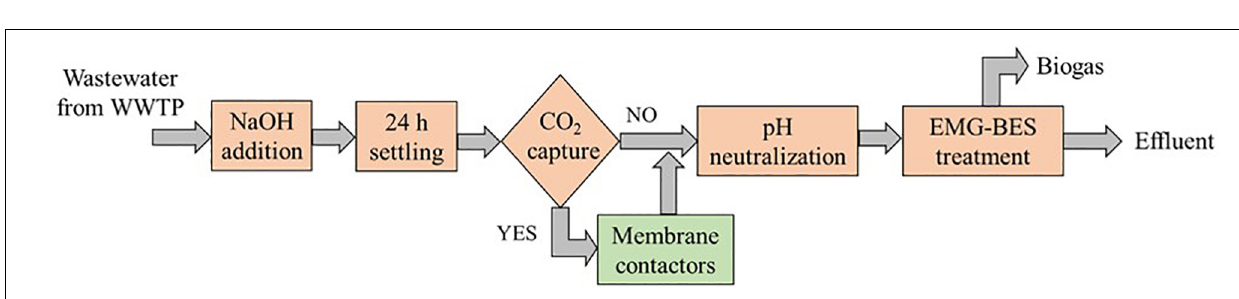
FIGURE 2 | Flow-chart showing the sequence of operations performed, from wastewater pre-treatment to CO 2 capture and EMG-BES stack operation.